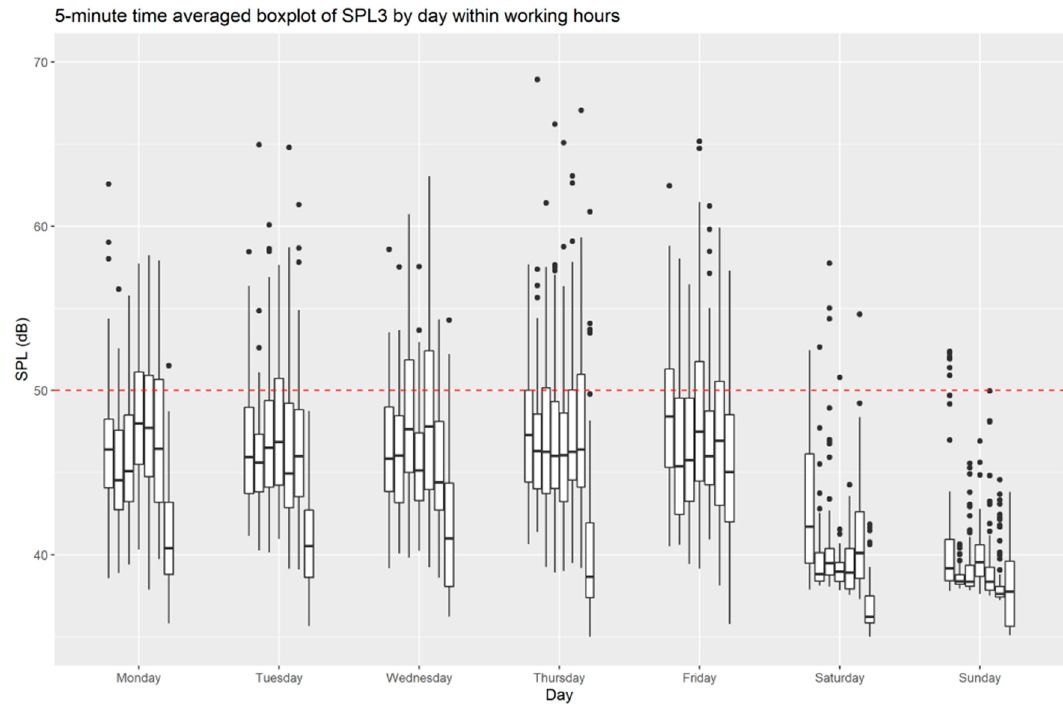
Figure 10. Boxplots of the 5 min averaged observations of sound pressure levels ( SPL ) collected from the open plan office in B1 during working hours (weekend included as baseline) for Stage 3. Red-dashed line denotes the recommended acoustic comfort threshold [38] for office space in the UK.